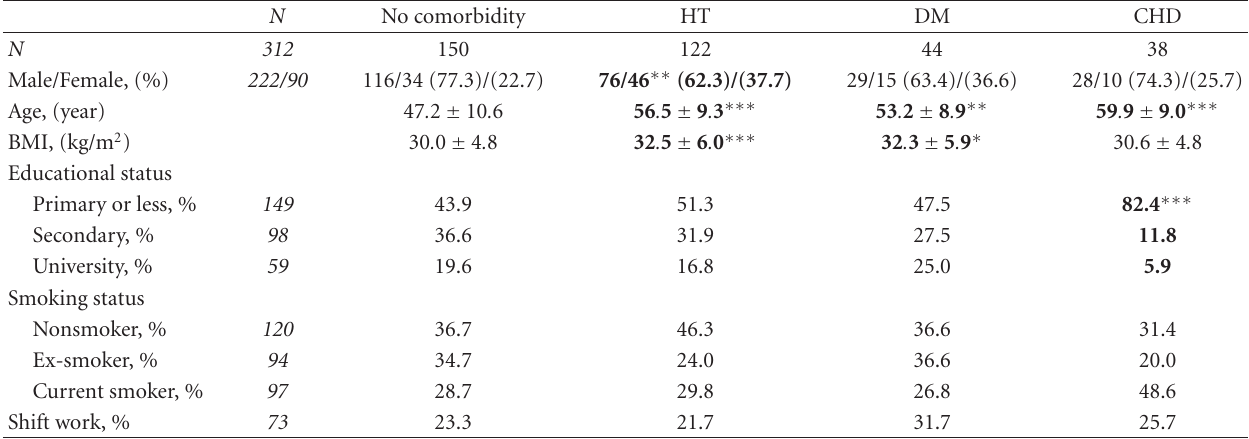
Table 1: Demographic features of the